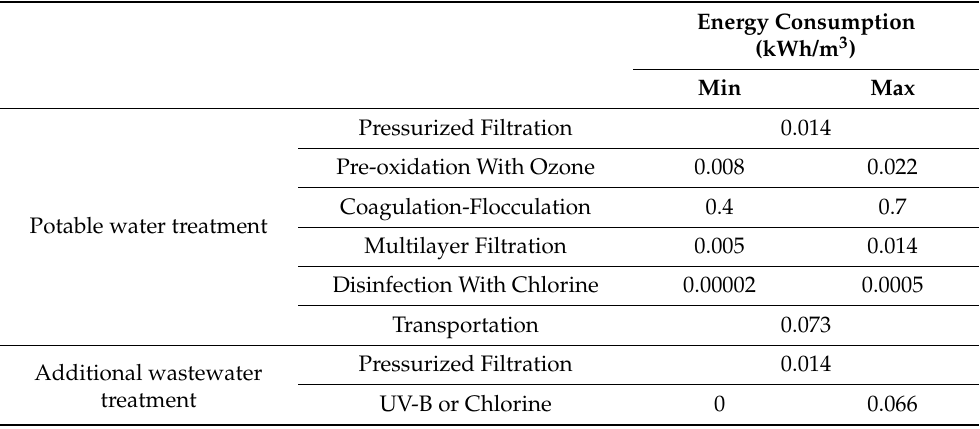
Table 1. Summary of unitary energy consumption for different stages of water and wastewater